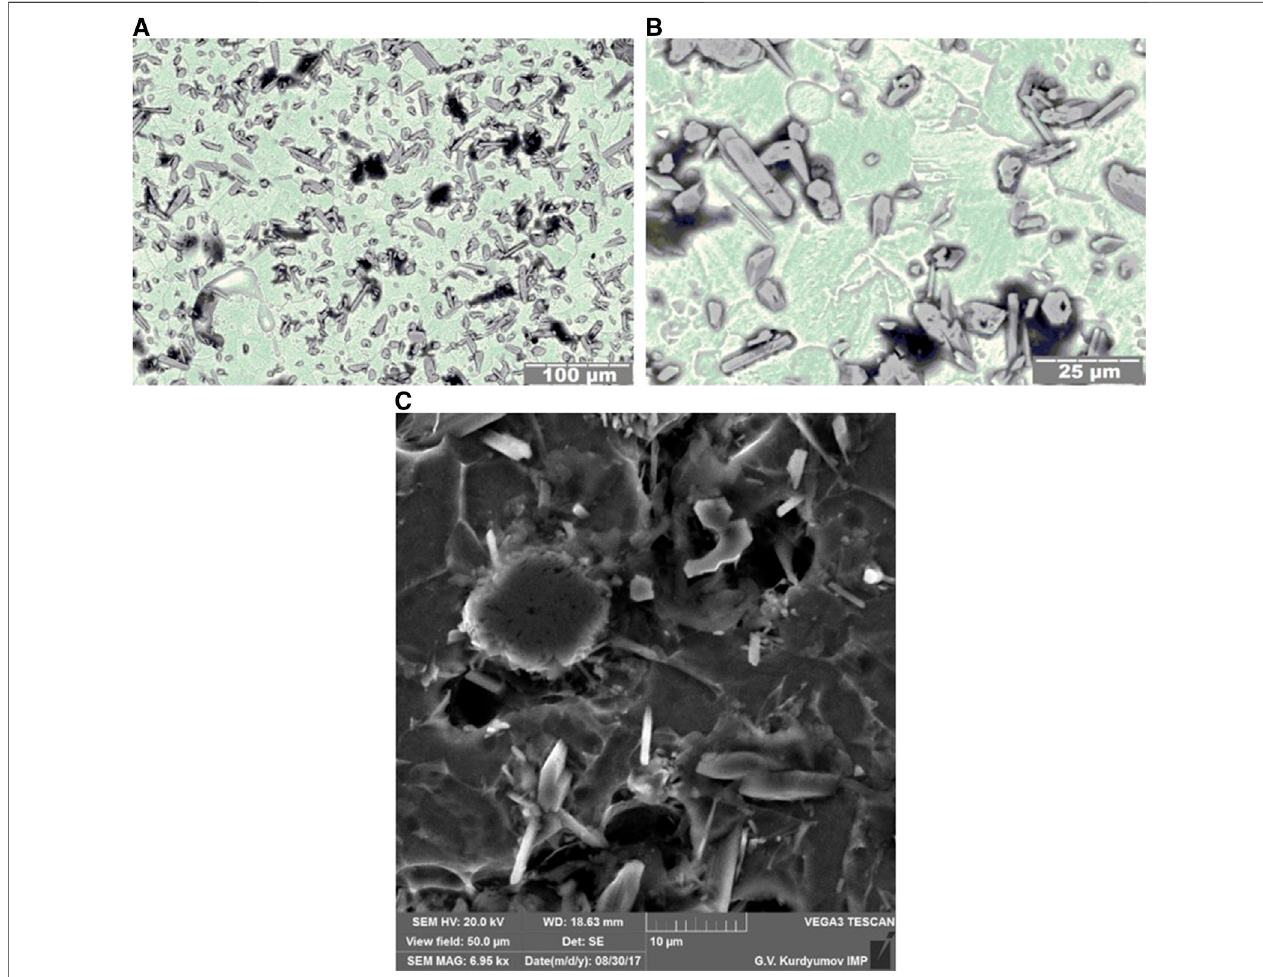
FIGURE 2 | Microstructures of Ti/8.4 vol% TiB samples fabricated via sintering at 1,250 ° C for 4 h (A,B) and typical morphology of boride inclusions showing not completely transformed equiaxed TiB 2 particle (C) .